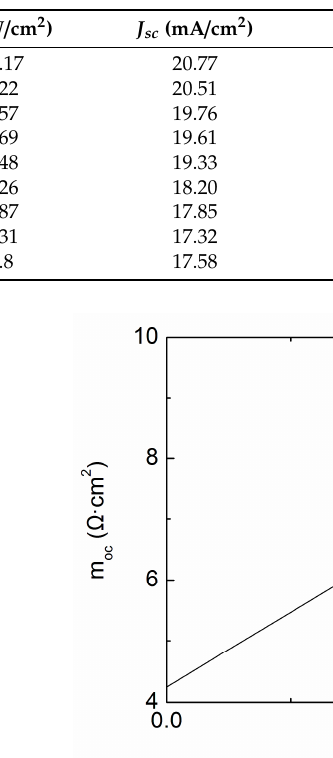
Figure 3. m oc − 1 versus exp(- qV OC /( nkT )) for extraction of R s for cell #1.